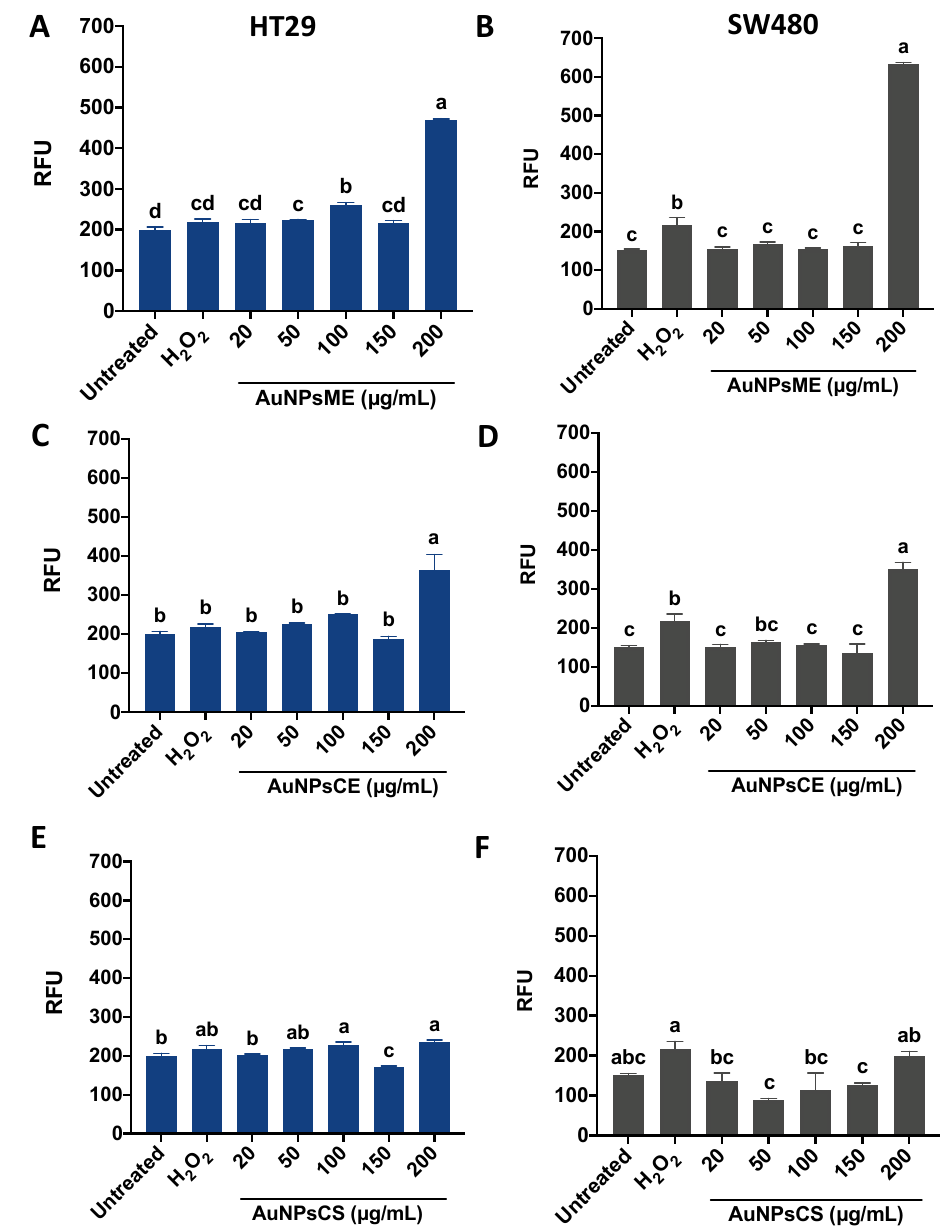
Figure 7. Intracellular reactive oxygen species (ROS) generation in HT29 and SW480 cells after treatments with common mullein ( V. thapsus ) ethanolic extracts-based gold nanoparticles (AuNPsME) ( A , B ); castor bean ( R. communis ) ethanolic extracts-based gold nanoparticles (AuNPsCE) ( C , D ); and gold nanoparticles made by chemical synthesis (AuNPsCS) ( E , F ). Different letters (a, b, c, d) in Figure 7A–F express significant differences ( p < 0.05) by Tukey-Kramer’s test. AuNPsCE: Gold nanoparticles synthesized with a castor bean ( R. communis ) leaves extract; AuNPsCS: Gold nanoparticles produced by chemical synthesis; AuNPsME: Gold nanoparticles synthesized with common mullein ( V. thapsus ) flowers ethanolic extract; RFU: Relative fluorescence units. Hydrogen peroxide (H 2 O 2 )-treated cells (30 mM) were used as a positive control. Untreated cells (DMEM + 0.5% ASB) were used as a negative control.